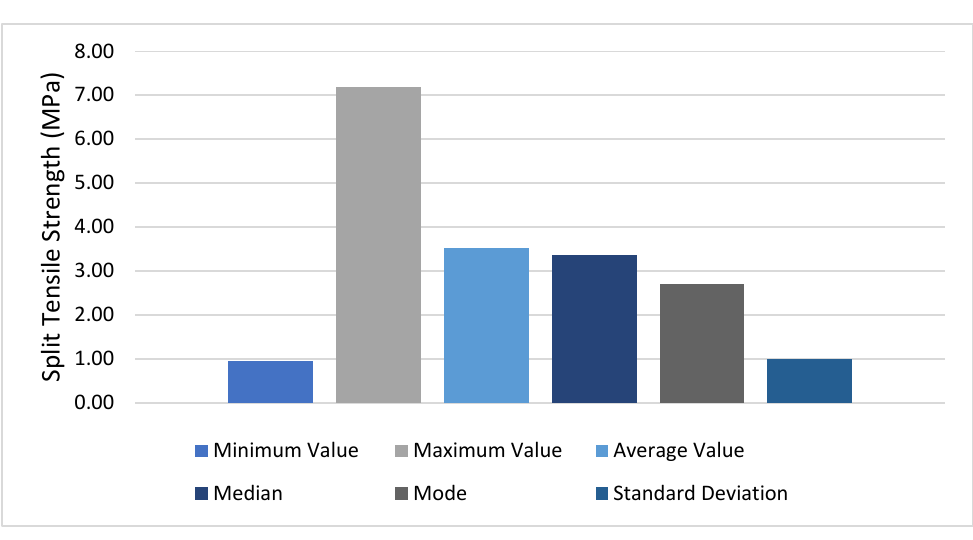
Figure 1. Statistical characteristics of input variables.